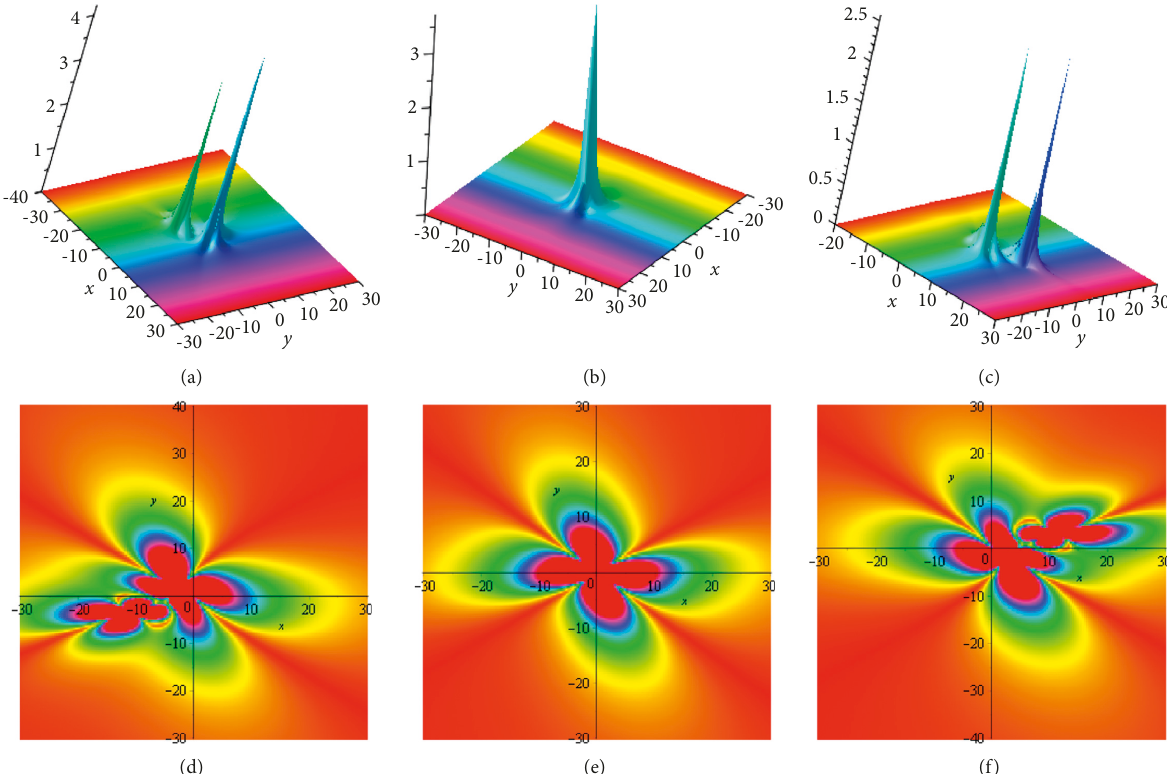
Figure 22: Plots of equation (83) by utilizing ϕ